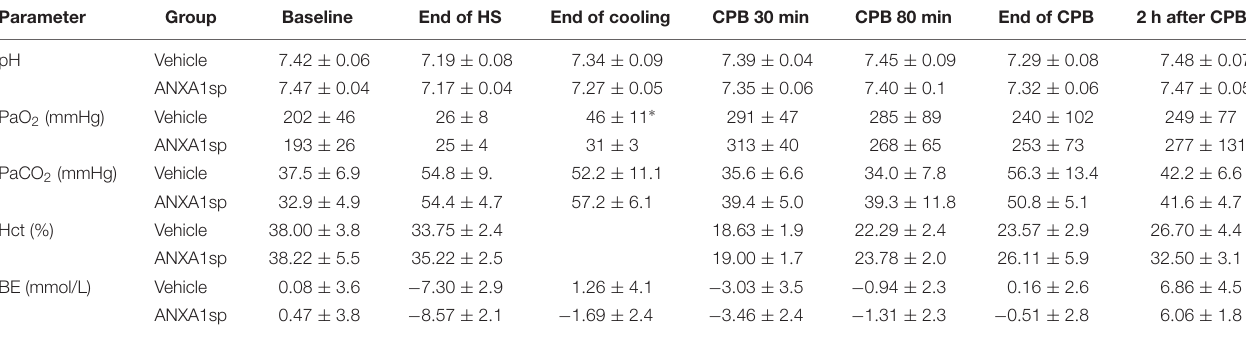
TABLE 1 | Physiologic